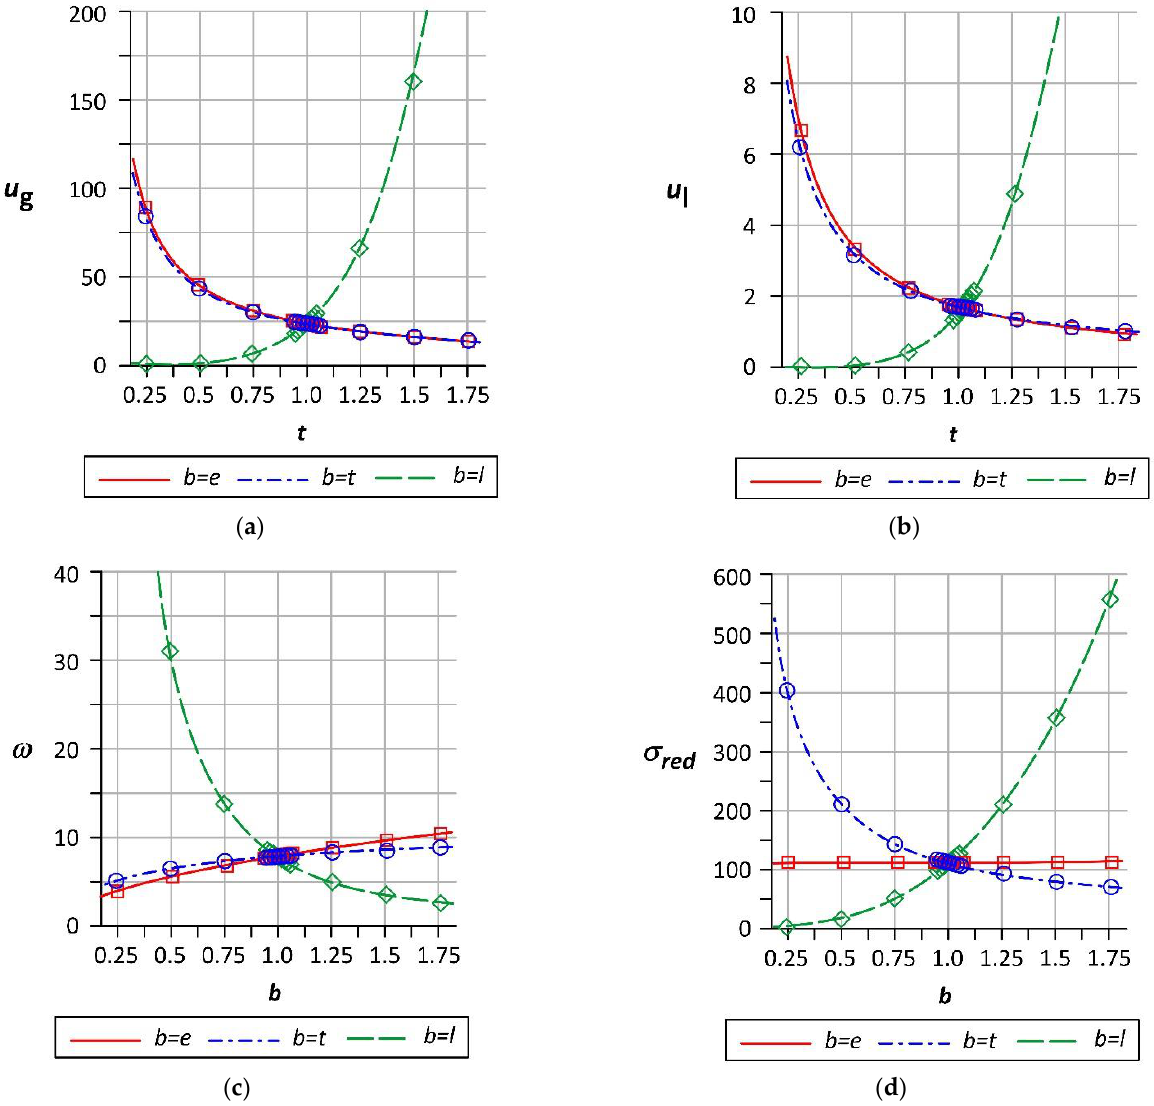
Figure 18. Diagrams of the finally adopted response functions and the extended FEM tests for the LS model: ( a ) the maximum of the global vertical displacements, ( b ) the maximum of the local deflections, ( c ) the basic eigenfrequency, ( d ) the extreme reduced stresses.